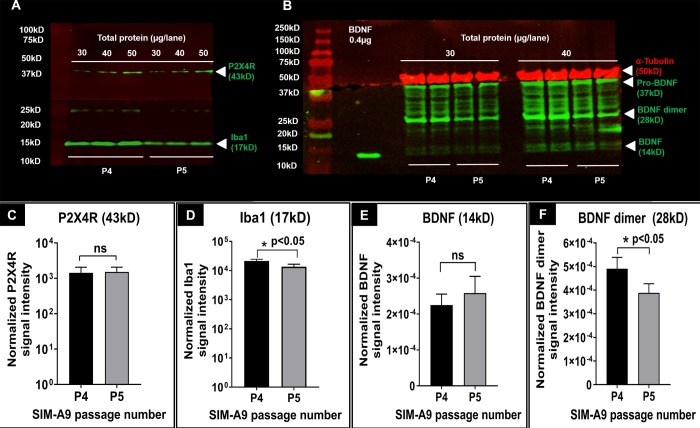
P2X4R, BDNF and Iba1 detection using western blotting.Western blot of P2X4R and Iba1 proteins (A), and α-tubulin, BDNF and its isoforms in SIM-A9 cell lysates (B) collected from different passages. In each blot, the series of bands on the left shows the protein ladder. For P2X4R and Iba1 (A), cell lysates collected from P4 and P5, at 30, 40, and 50μg/lane total protein were used to detect P2X4R (green, 43kD) and Iba1 (green, 17kD) on the 800 nm channel. The signals at about 25 kD are due to the non-specific reactivity of secondary antibody. For α-tubulin and BDNF (B), cell lysates at 30 and 40 μg/lane total protein were electrophoresed to identify α-tubulin (50 kD), BDNF monomer (14 kD), BDNF dimer (28 kD), and pro-BDNF (37 kD) on the 700 nm and 800 nm channels, respectively. The blots were scanned using an Odyssey imager at intensity setting 5 and processed using ImageStudio 5.2 software. Each sample was run in triplicates (A) or duplicates (B). C-F. Densitometry analysis of P2X4R, Iba1, BDNF, and BDNF dimer bands was performed using ImageStudio 5.2 software. Signal intensities of P2X4R (C) and Iba1 (D) bands were normalized for protein loading. Signal intensities of BDNF (E) and BDNF dimers (F) were first normalized to α-tubulin and then to the amount of protein loaded. Statistical analysis between P4 and P5 was performed by unpaired t-test and Welch’s correction using GraphPad Prism 8.1.2. Asterisks indicate statistically significant differences (* p<0.05). Blots were merged and cropped for the clarity and conciseness of the presentation. Full-length blots are presented in S3A and S3B Fig, raw blots A and B.